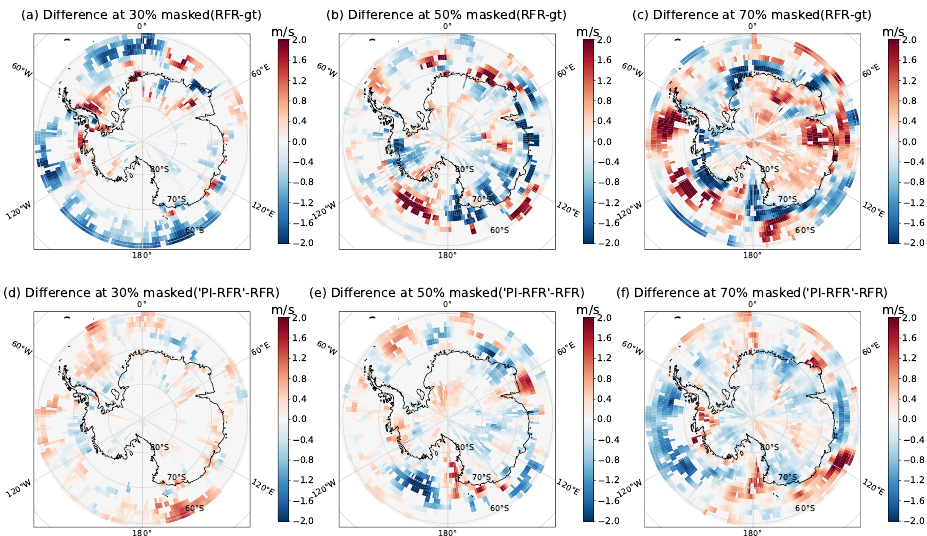
Figure 11. Differences between the reconstructed wind speed of RFR ( a – c ) and PI-RFR ( d – f ) and the ground truth with 30%, 50% and 70% missing rates,